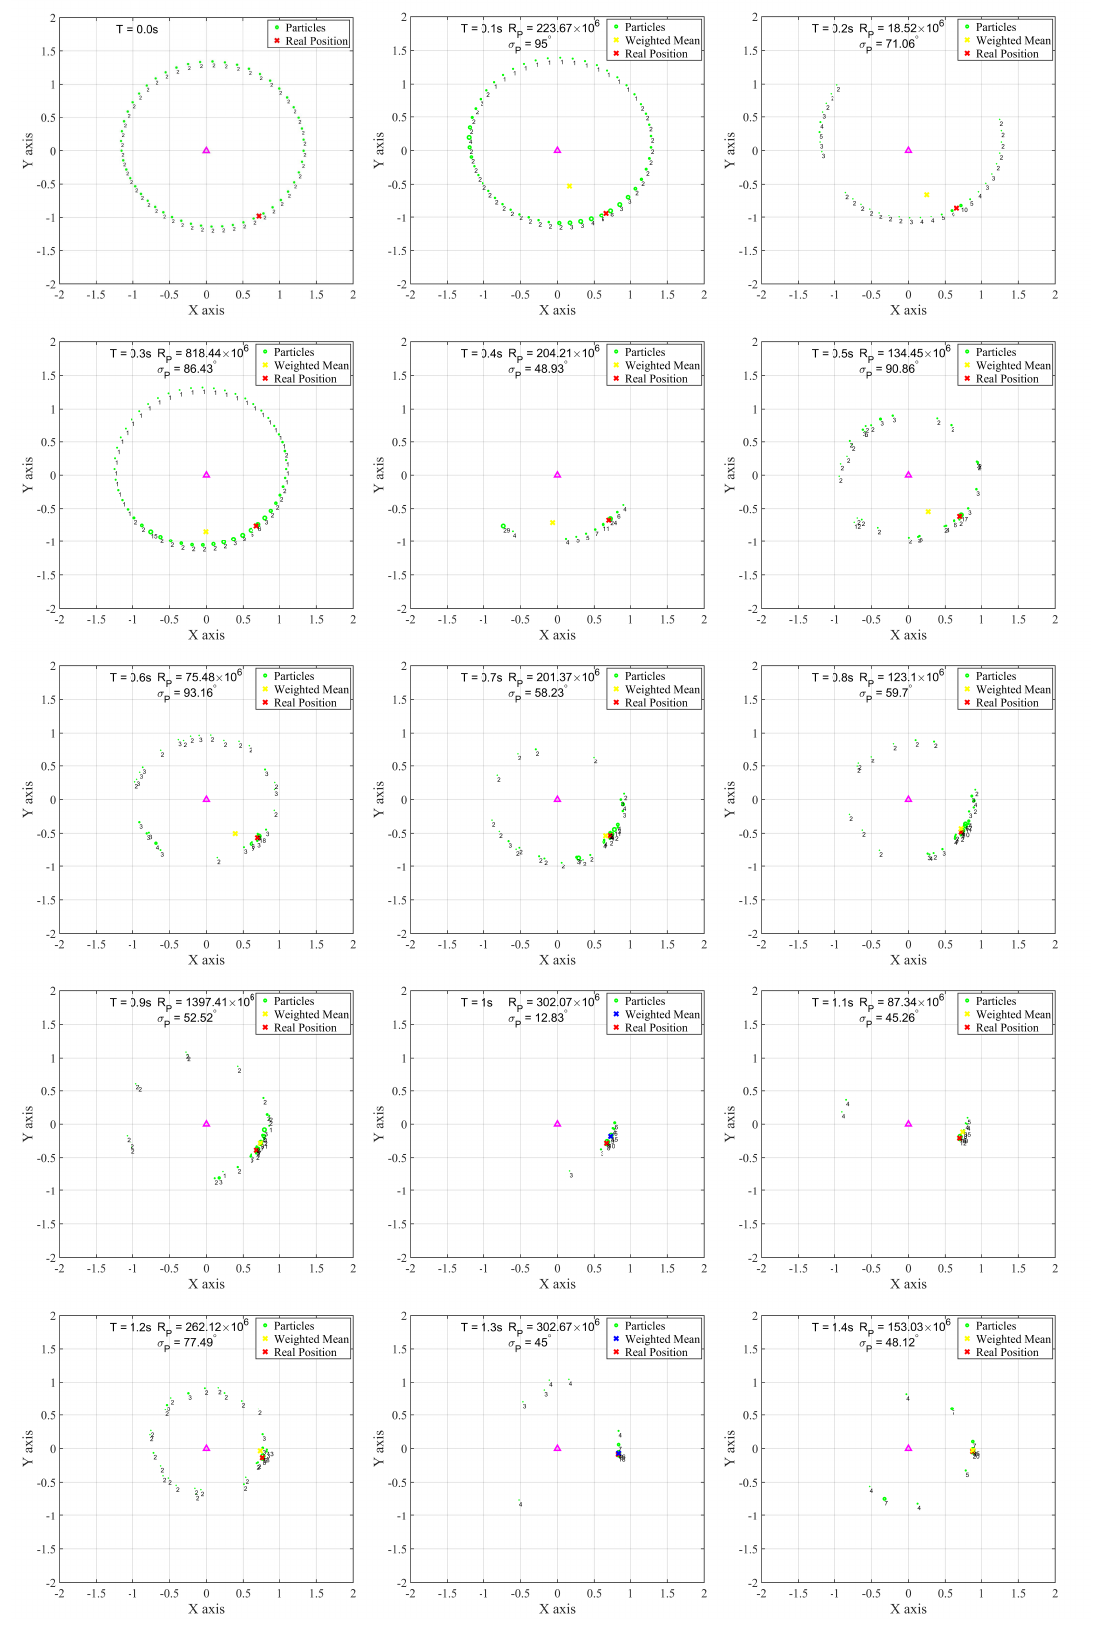
Figure 7. Timeline representation of the particle update